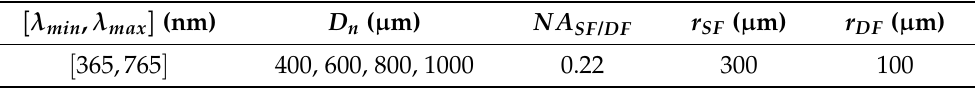
Table 1. Values of the geometrical and spectral source–detector features for the SR-DRS simulation.